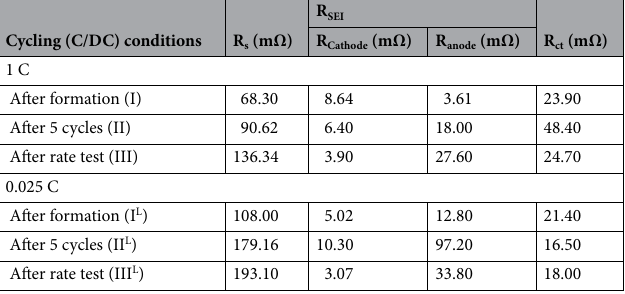
Cycling (C/DC) conditions R s (mΩ)